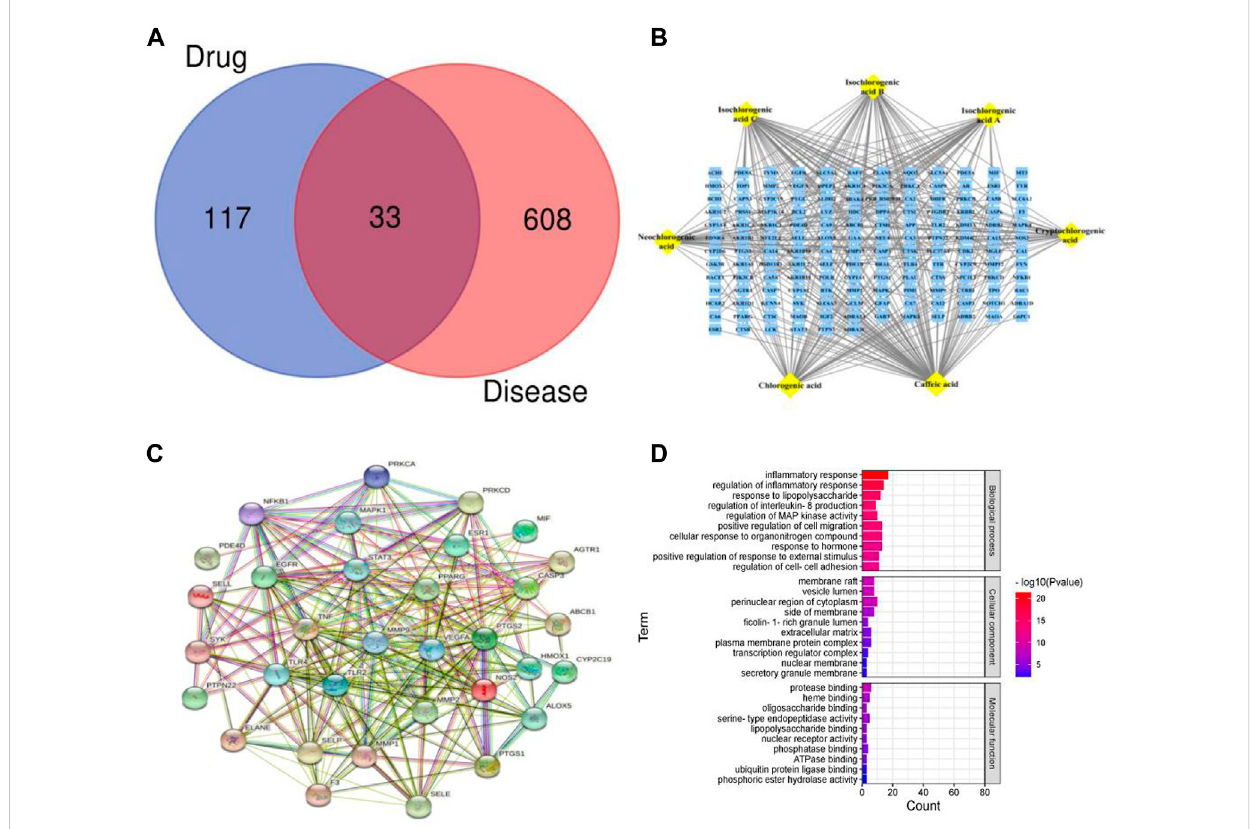
FIGURE 8 Network analysis of PS in treating nephritis. (A) Venn diagram of the 7 phenolic acids and targets of nephritis; (B) Compound-target network for the 7 phenolic acids; (C) PPI interaction network diagram; (D) Top 30 enriched GO terms for the biological processes of the potential targets.